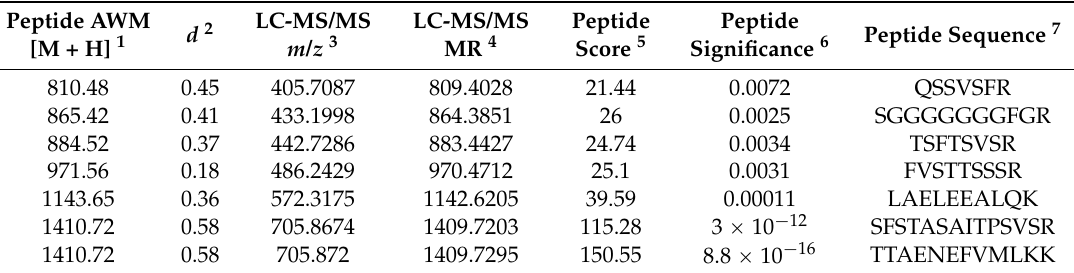
Table 2. CK5 matrix-assisted laser desorption/ionization mass spectrometry imaging peak groups of interest with matched nanoflow liquid chromatography tandem mass spectrometry